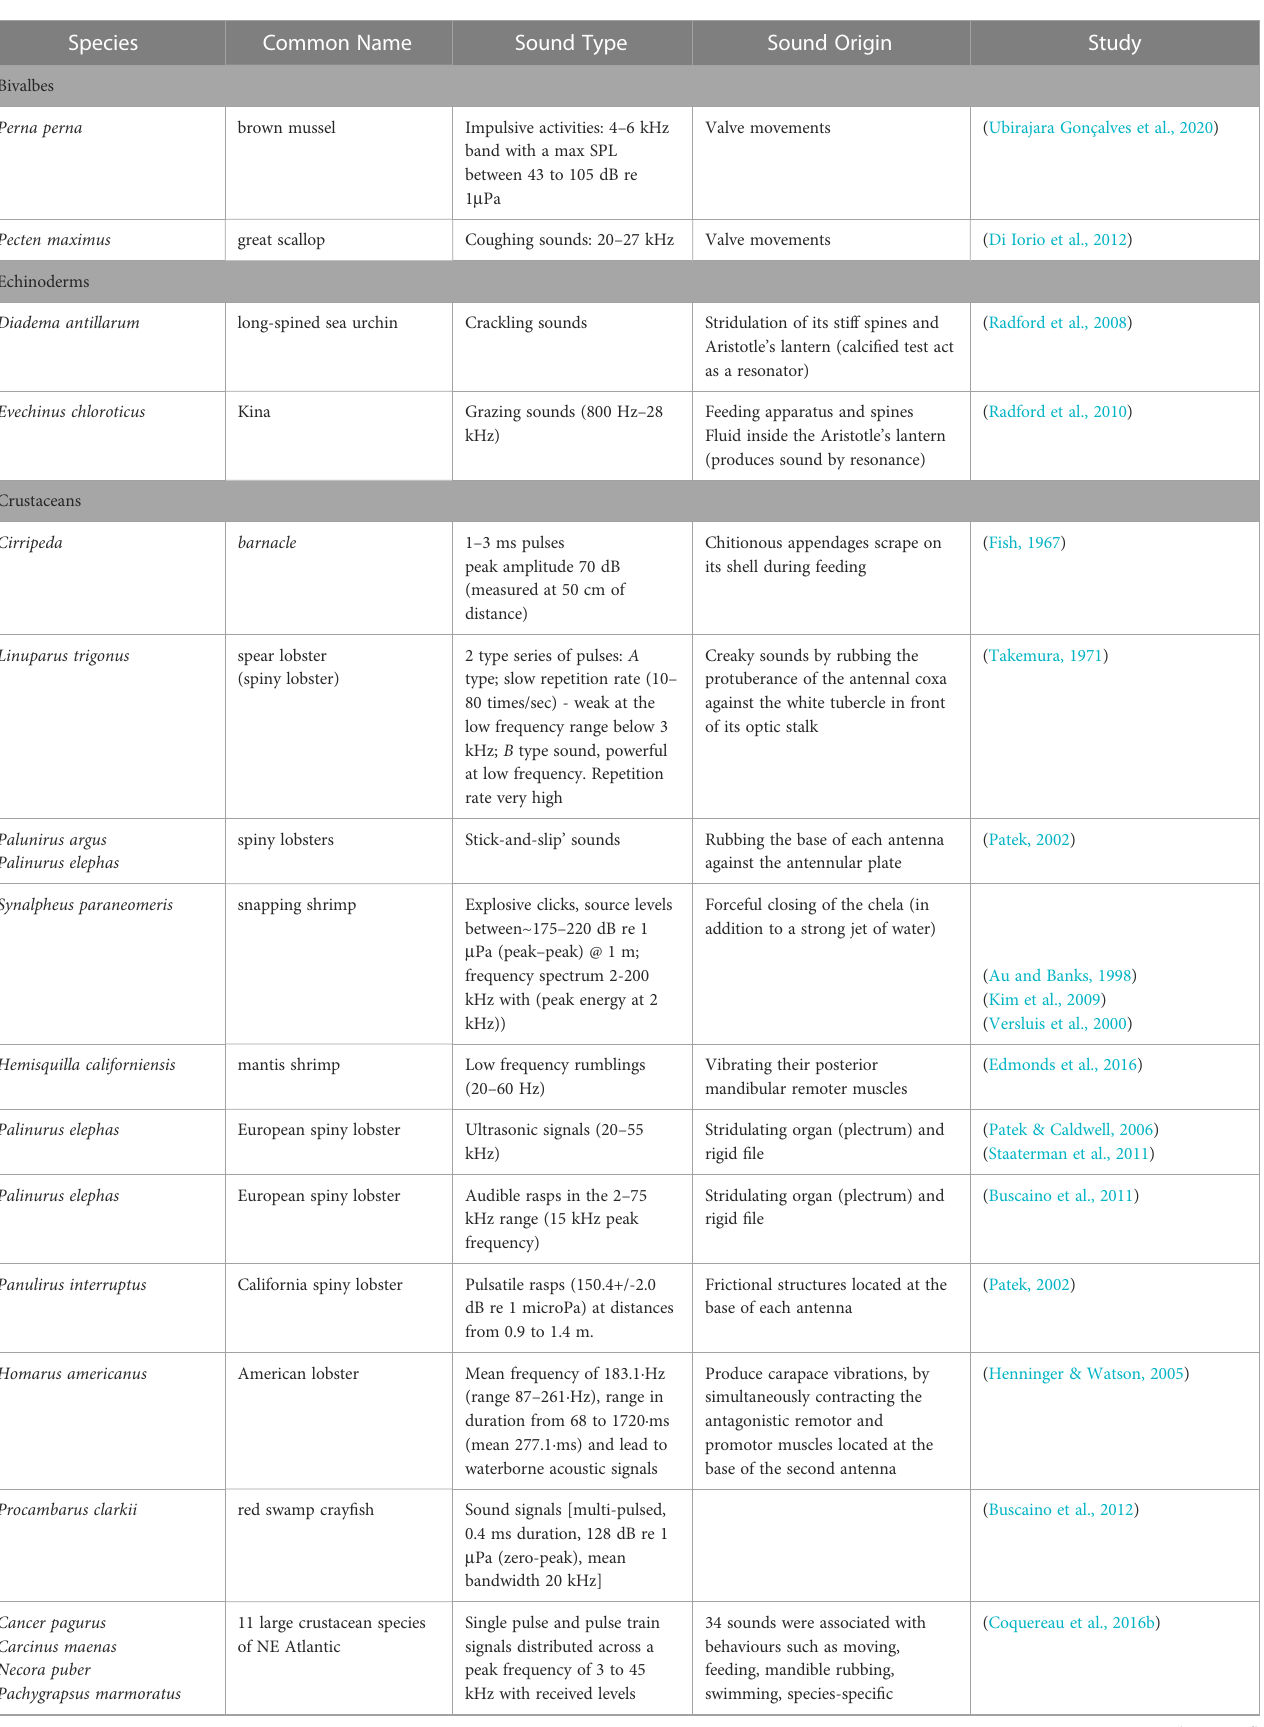
TABLE 3 Relevant studies on sound production on marine